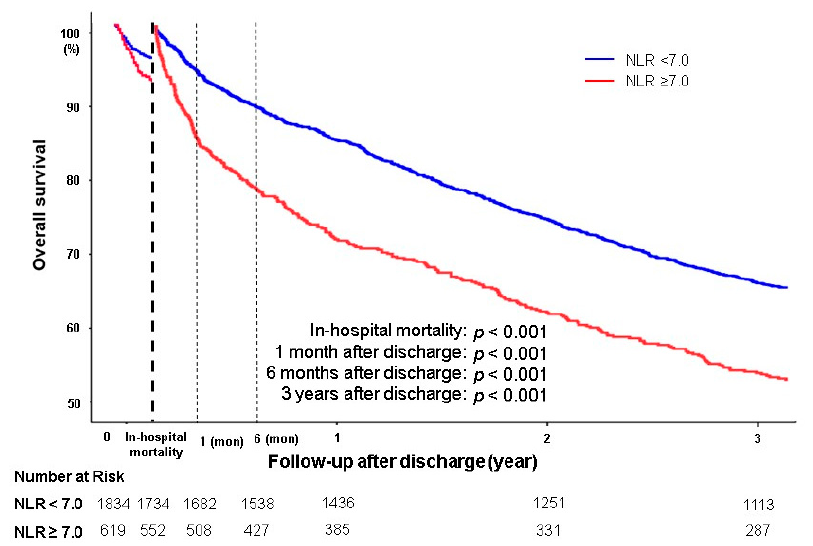
Figure 4. Overall in-hosptial mortality and 3-year survival after discharge of HF patients whose aggravating factor were infection or ischemia divided by NLR 5.0. Table 6. Univariate and multivariate logistic regression analyses for all-cause in-hospital and post discharge 3-year mortality in HF patients subgroup analysis by aggravating factor stratified by neutrophil-lymphocyte ratio (NLR) cutoff value. (A)Patients whose aggravating factor were not infection or ischemia In-Hospital Mortality ( n = 3127)